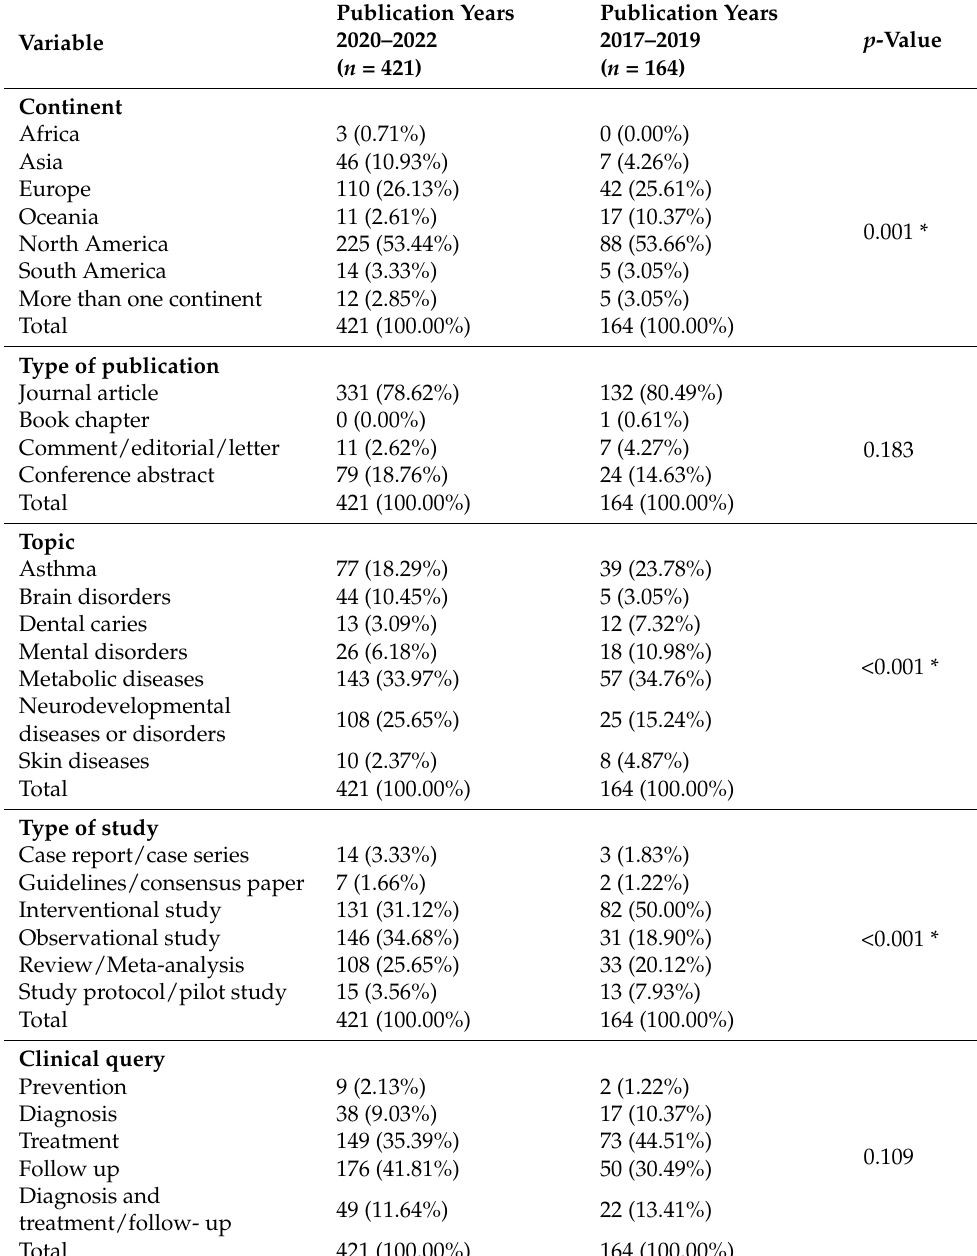
Table 1. Data comparison according to publication